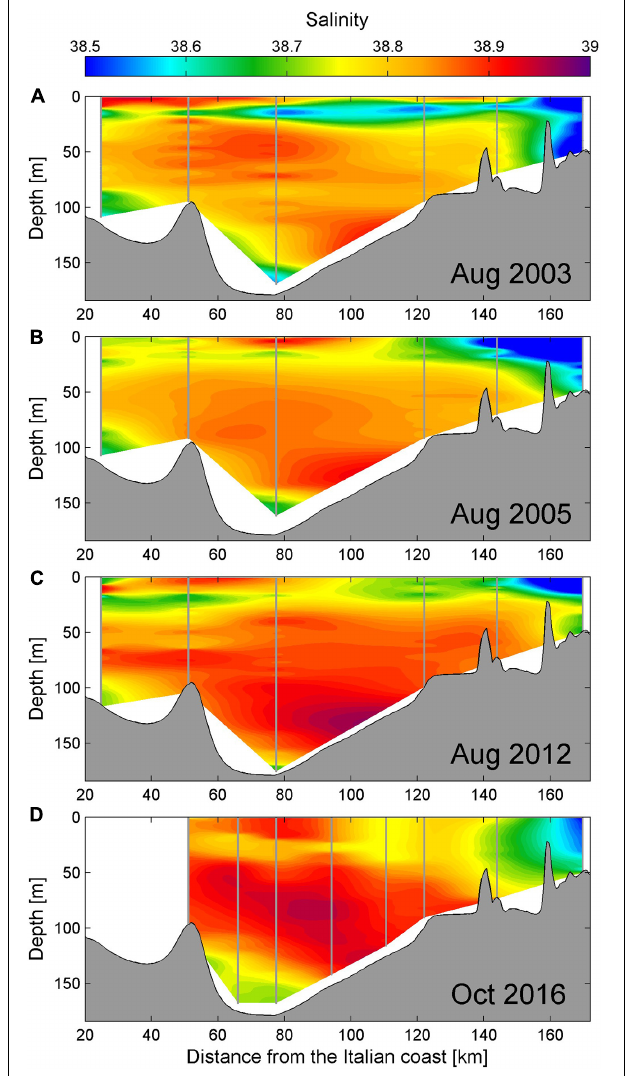
FIGURE 11 | (A) Salinity profile at the Palagruža Sill transect in the second half of August 2003. (B–D) As in panel (A) except for mid-August 2005, the second part of August 2012 and the beginning of October 2016, respectively. Vertical gray lines denote CTD